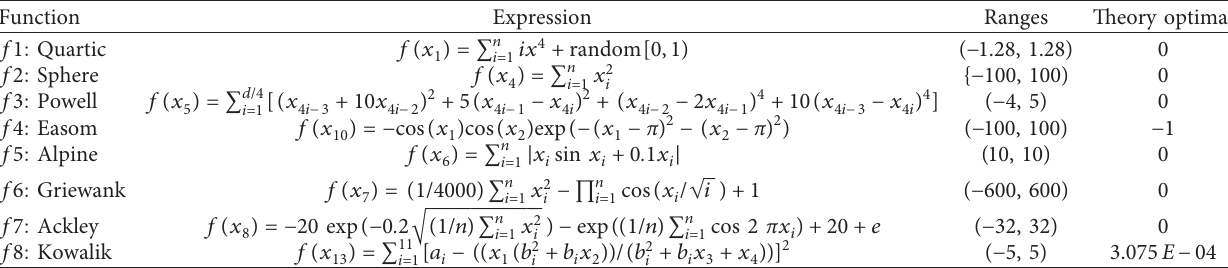
Table 1: Test function.